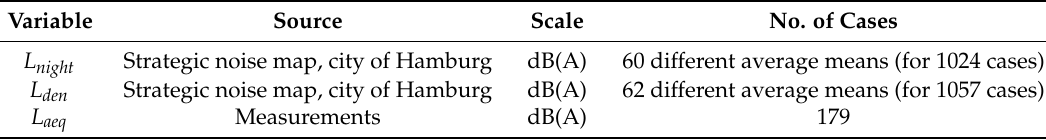
Table 3. Noise variables (data L den and L night [53,54]).